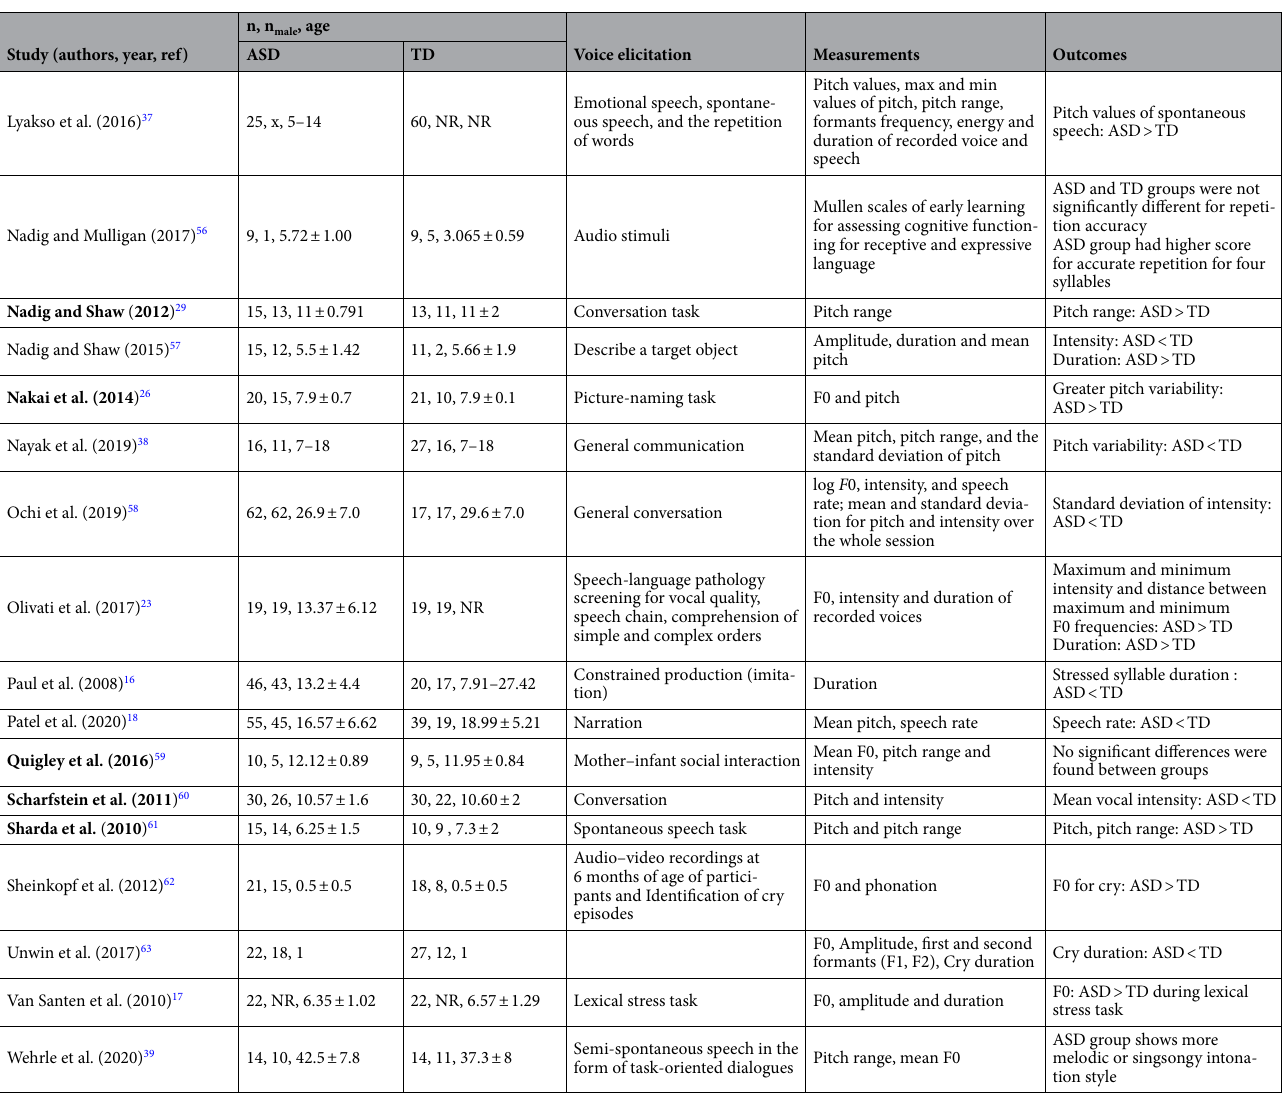
Table 1. Summary of included studies. The bold studies are related to the included studies in the last performed meta-analysis by Fusaroli et al. 35 . NR shows to not reported